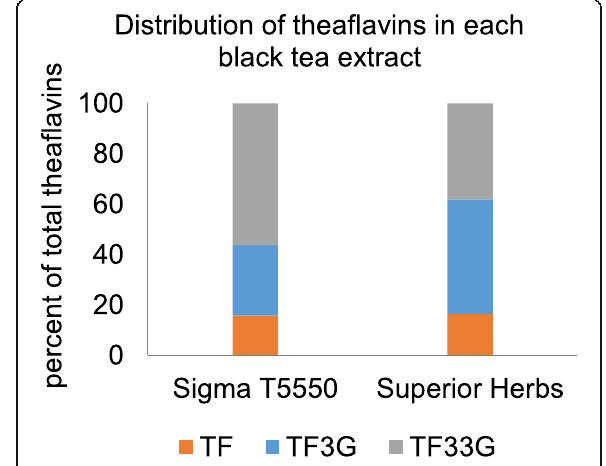
Fig. 3 Relative amounts of the three theaflavins as a percent of total theaflavins for the two black tea extracts